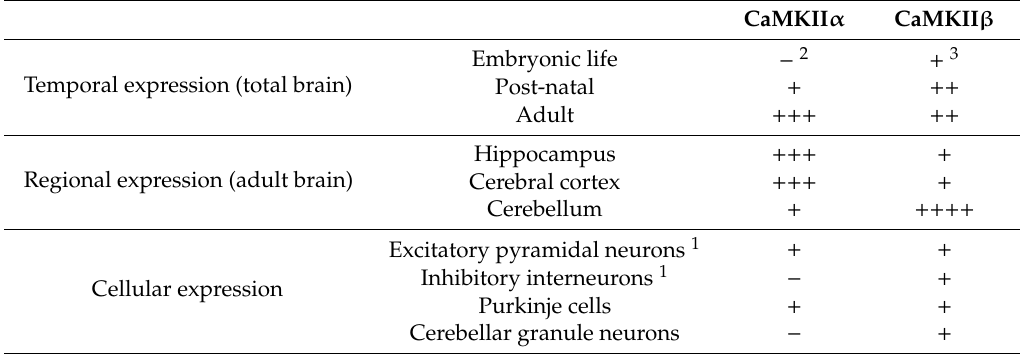
Table 1. Schematic representation of temporal and regional expression of CaMKII α and CaMKII β